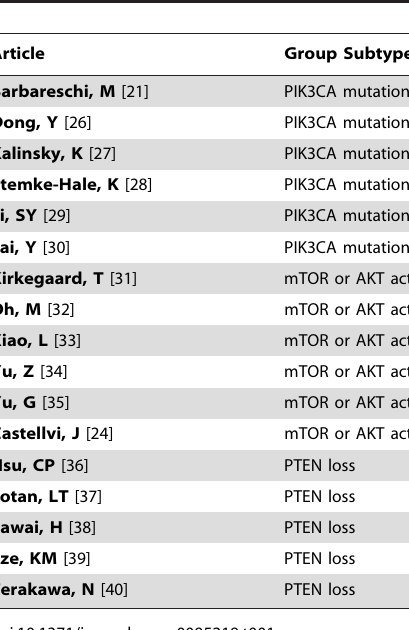
Table 1. Characteristics of included